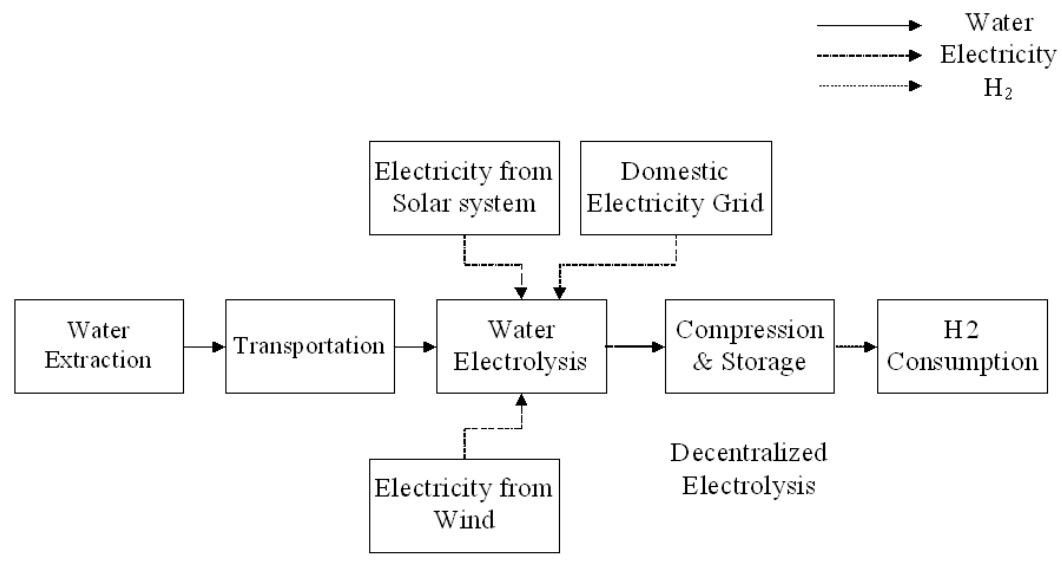
Figure 5. Hydrogen production process via water electrolysis, representing decentralized form of hydrogen refuelling station.